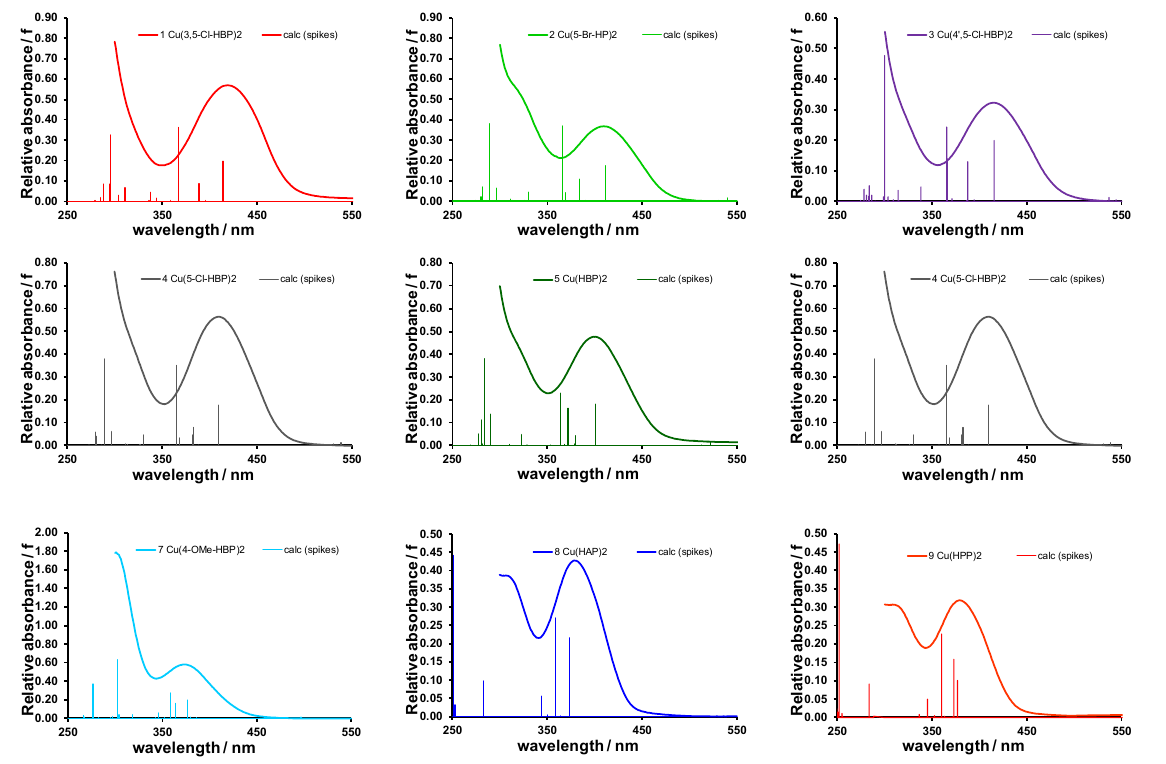
Figure 4. Experimental absorption spectra of the Cu(II) complexes ( 1 )–( 9 ) in DMSO (smooth curves) overlaid with the B3LYP/6-311G(d,p)/def2-TZVPP calculated oscillators (bar graphs of wavenumber versus the oscillator strengths). The B3LYP/6-311G(d,p)/def2-TZVPP method shows three obvious calculated absorp-